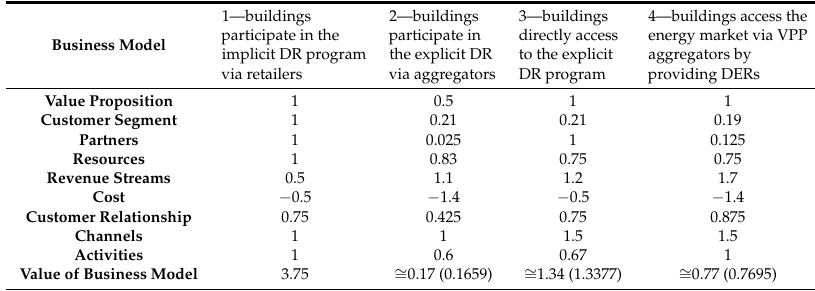
Table 11. Value of four developed business models in the Nordic electricity market. Business Model